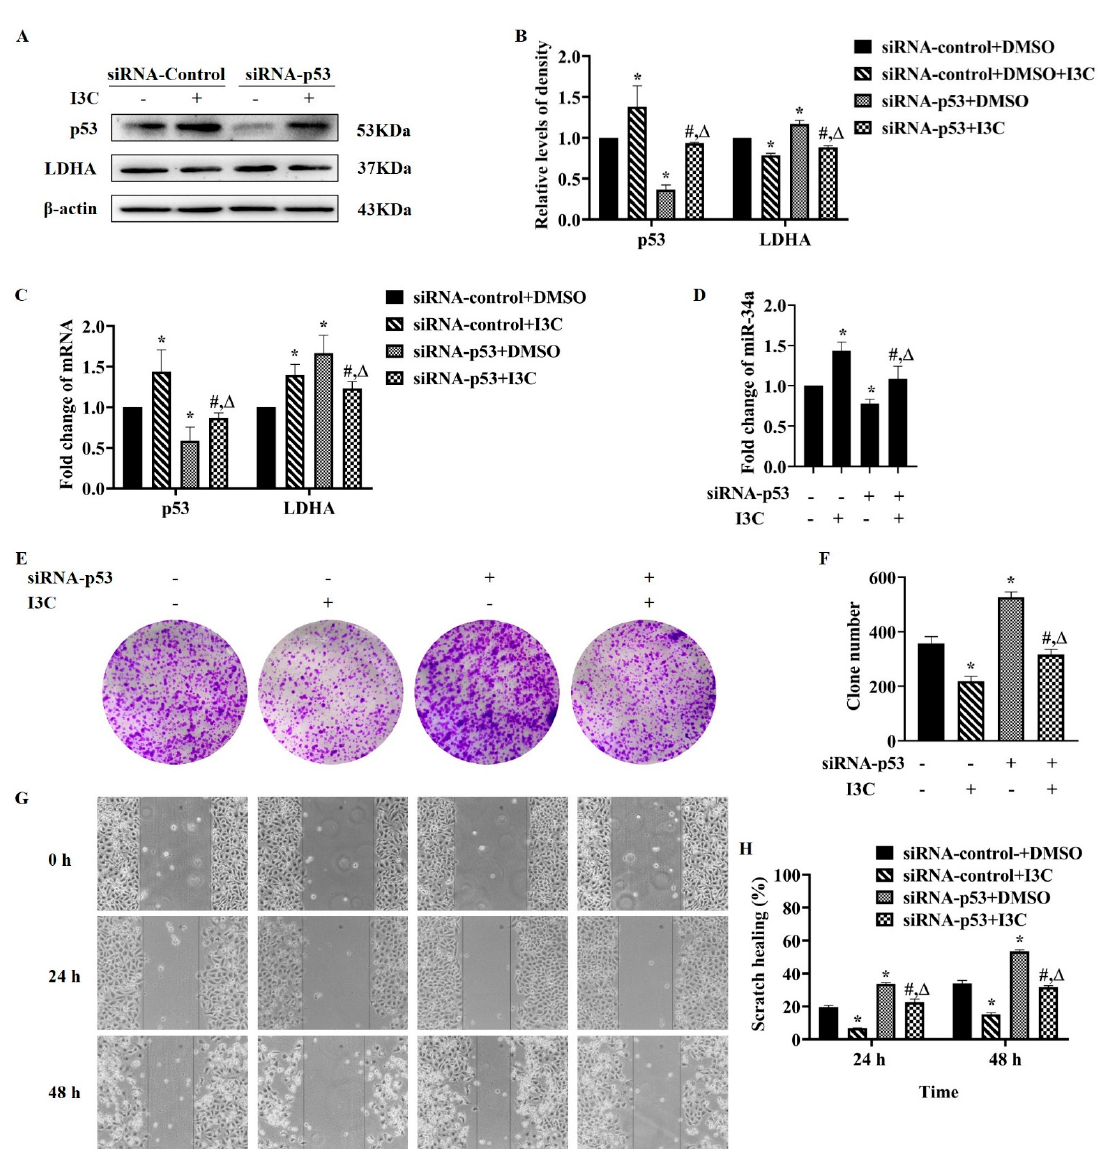
Figure 4. I3C regulated LDHA expression through miR − 34a in a p53-dependent manner. HepG2 cells were treated with I3C and siRNAs alone or in combination. ( A ) The effects on the protein expression of p53 and LDHA; ( B ) Densitometric analysis for blots shown in ( A ). * p < 0.05 vs. siRNA − control+ DMSO, # p < 0.05 vs. siRNA − control +I3C; ( C ) Measurement of the mRNA levels of p53 and LDHA; ( D ) The effect on the expression of miR-34a; ( E ) Colony formation assay. (×40); ( F ) Statistical analysis using the colony numbers; ( G ) Wound scratch assay. (×10); ( H ) Wounded area, shown as an arbitrary unit. * p < 0.05 vs. siRNA − control+ DMSO, # p < 0.05 vs. siRNA − control +I3C, Δ p < 0.05 vs. siRNA − p53+ DMSO. PFT- α , as an inhibitor of p53 transcription activity, was used to further confirm the relationship between p53, miRNA, and LDHA. Based on CCK8 analysis (Figure S1), we chose 20 μ M of PFT- α for the 12 h treatment for the following experiments. Firstly, PFT- α